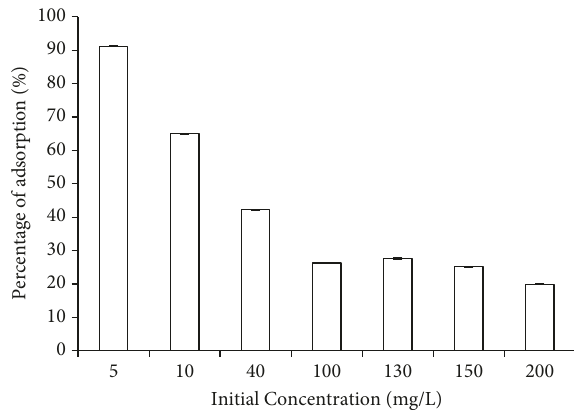
biofilm. The experiment was repeated three times, independently (average values are shown). Bars represent the standard error; however, the bars are not clearly visible due to the small values of standard errors.